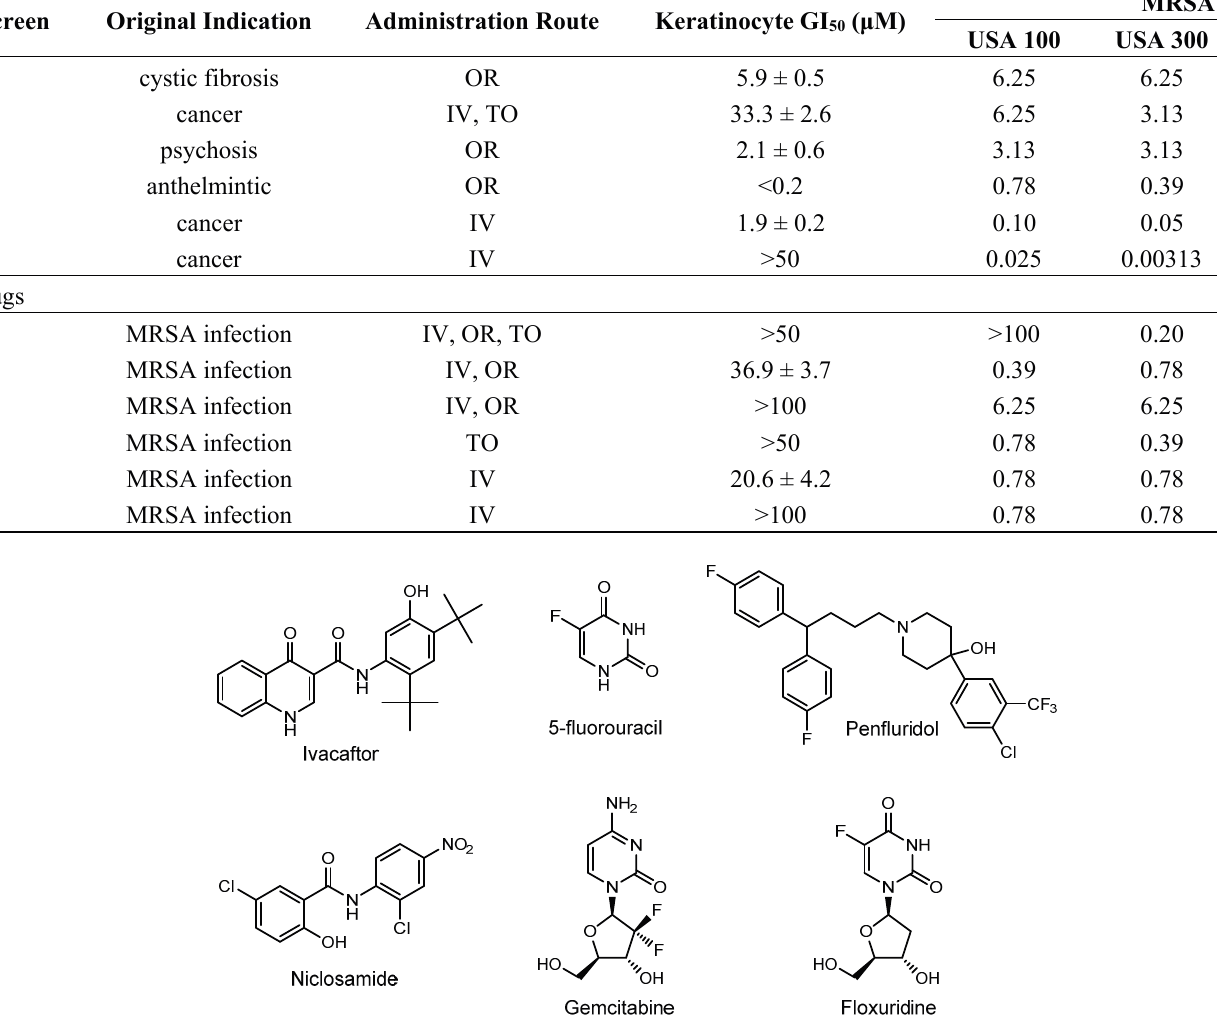
Table 1. Drug data, GI 50 s and MICs against various MRSA strains. Abbreviations: IV, intravenous; OR, oral; TO, topical. Drugs Found in This Screen